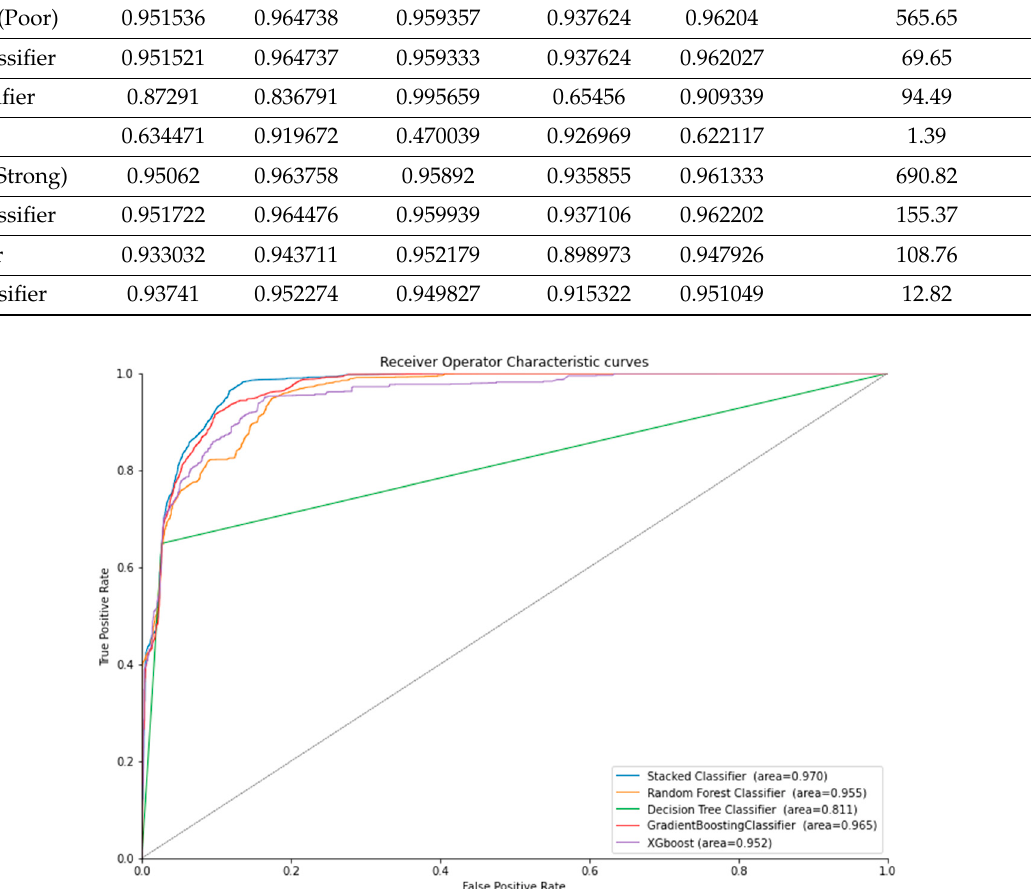
Figure 3. The ROC curve for the NSL-KDD dataset.